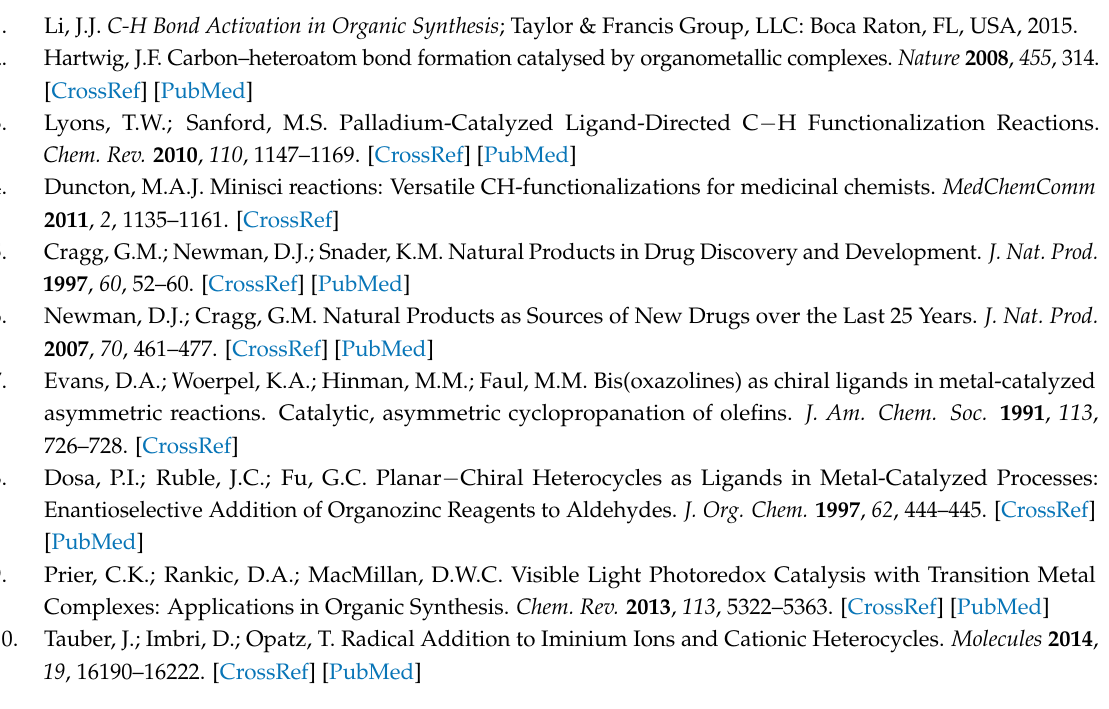
Supplementary Materials: The following are available online, Figure S1: Setup for irradiation with a 100 W blue LED module. Figure S2: Emission spectra of the 100 W blue LED module. The spectra was recorded with an USB2000+ from Ocean Optics, Inc., Dunedin, FL, USA. Wavelength range from 200–523 nm, optical resolution 1 nm. Table S1: Catalyst loading studies. Table S2. Solvent screening for the photoredox Minisci-type reaction. Table S3. Additive screening for the photoredox Minisci-type reaction. Table S4. Equivalent screening of isoquinoline. Figure S3. UV-Vis absorption spectra at 290–500 nm measured for A) N -(cyclohexylcarbonyloxy)phthalimid (1 × 10 − 4 M), B) isoquinoline (1 × 10 − 4 M), p -toluenesulfonic